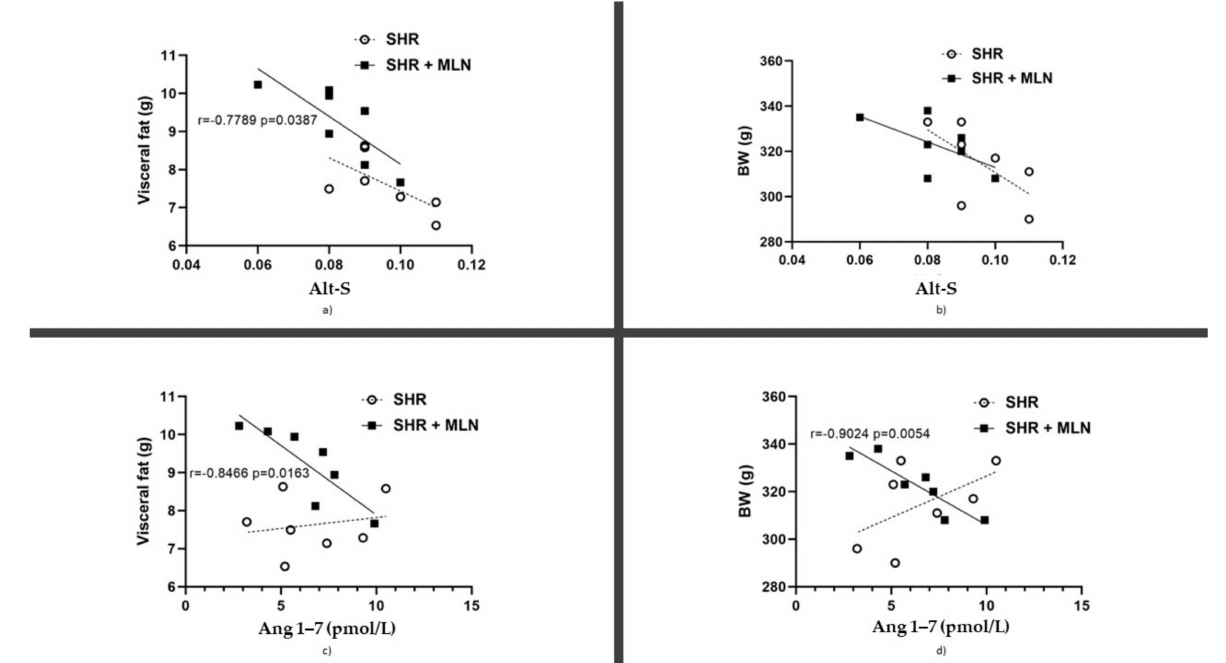
Figure 2. The correlation between the plasma level of the total alternative renin angiotensin system activity (Alt-S) and the weight of the visceral fat ( a ) and body weight ( b ). The correlation between the plasma level of angiotensin 1–7 (Ang 1–7) and the weight of the visceral fat ( c ) and body weight ( d ) in SHRs and SHRs treated with MLN-4760 (SHR +